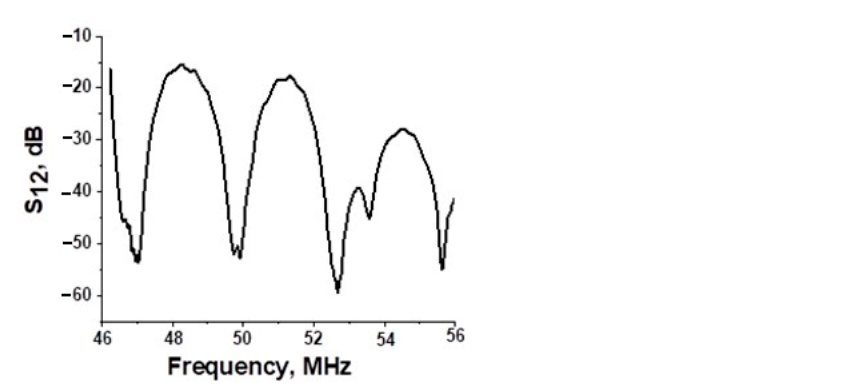
Figure 4. Insertion loss of the acoustic delay line based on ZnO-1/Si/ZnO-2 layered structure (Figure 2b) and acoustic plate modes propagating with different phase velocities. Si substrate thickness is 380 μ m. ZnO film thicknesses are h ZnO-1 = 8.8 μ m, and h ZnO-2 = 5.6 μ m. IDT period λ = 146 μ m.